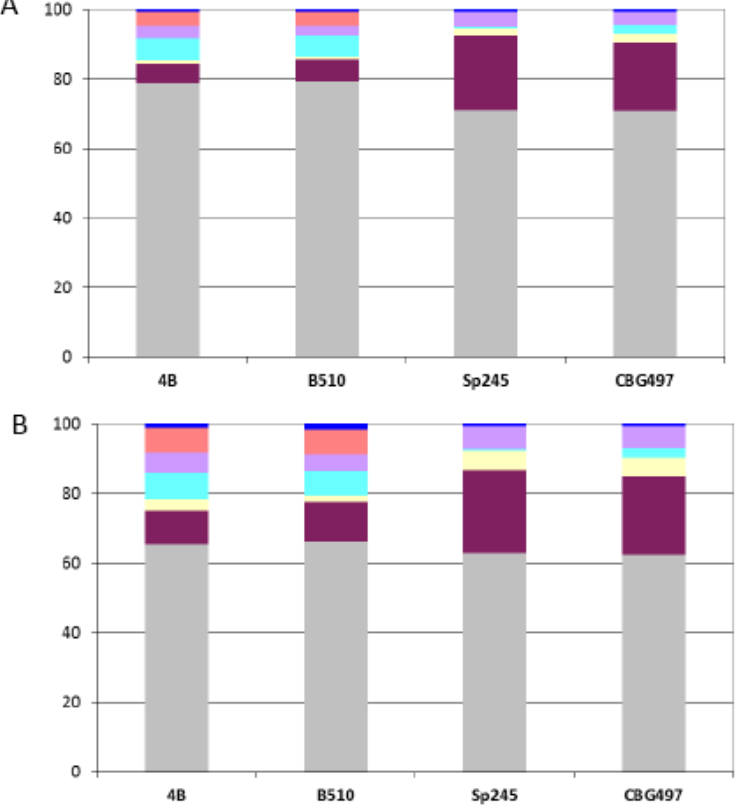
Figure 3. Repartition of orthologous groups among replicons for each Azospirillum strain. (A) Repartition of the 1,151 Azospirillum - Rhodospirillum orthologous groups (ANC-core). (B) Repartition of the 2,328 Azospirillum orthologous groups (AZO-core). Color legend: Grey (chromosome), burgundy (p1), yellow (p2), light blue (p3), purple (p4), orange (p5), dark blue